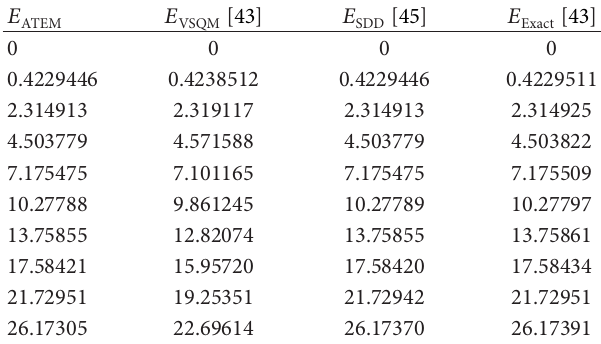
Table 3: Comparison of energy eigenvalues of the potential in (20). For ATEM results, number of iterations is set to 𝑚 = 120